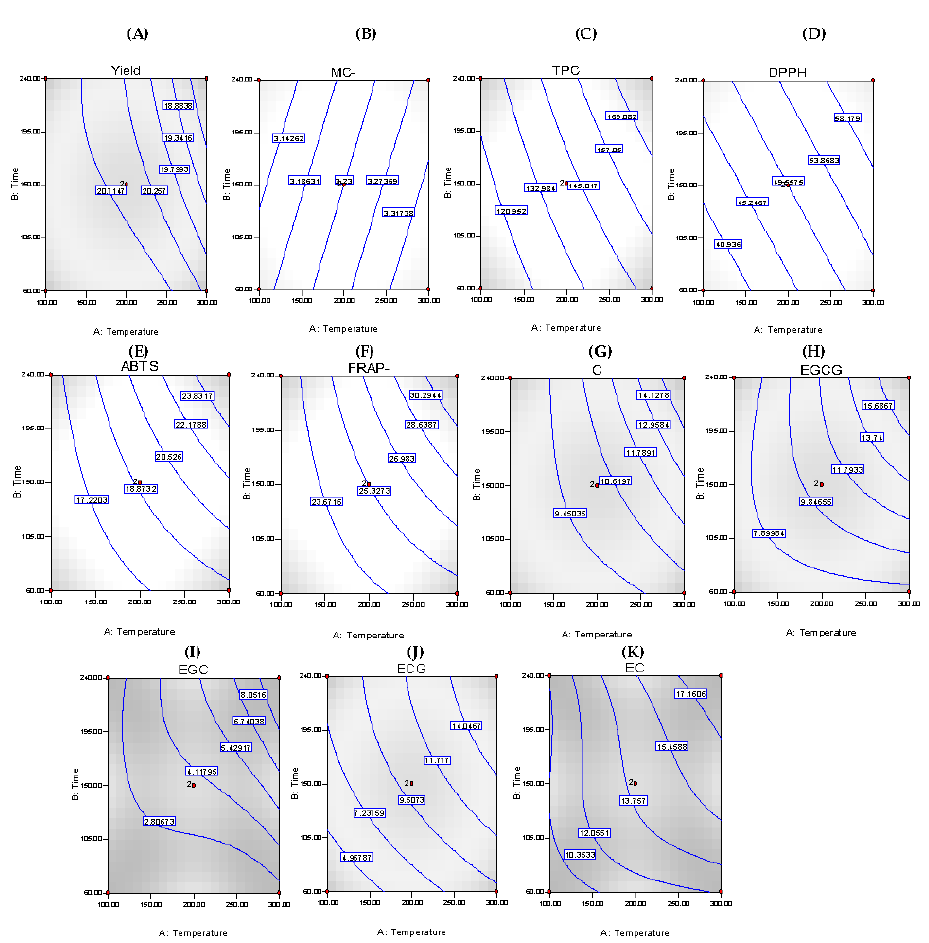
Figure 2. Response surface plots showing the effect of roasting temperature and time on production yield ( A ), moisture content ( B ), total phenolic content ( C ), DPPH ( D ), ABTS ( E) , FRAP ( F ), catechin ( G ), epigallocatechin gallate ( H ), epigallocatechin ( I ), epicatechin gallate ( J ), epicatechin ( K ). 3.2. Effect of Roasting Temperature and Time on Green Tea Antioxidant Activity The total antioxidant capacity of green tea produced at different roasting temperatures and times was determined. The antioxidant activity determined by TPC, DPPH, ABTS and FRAP was in the range from 80.45 to 169.64 mg GAE/g dw, 28.97 to 60.16 mg GAE/g dw, 18.34 to 28.51 mg GAE/g dw and 12.76 to 24.65 mg GAE/g dw, respectively (Table 1).